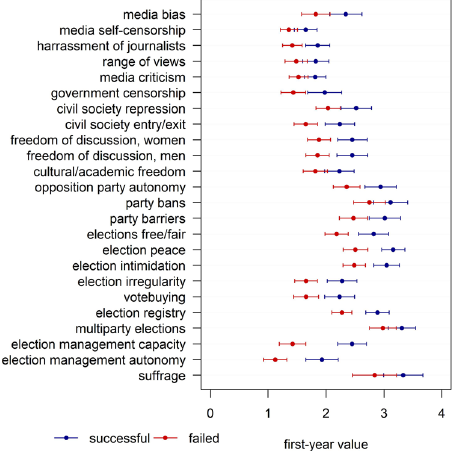
Fig. 2 Initial conditions of 24 democracy indicators for successful and failed liberalization episodes. Successful (blue) and failed (red) episodes signi fi cantly differed on 16 of the 24 democracy indicators in the year the episode began (99.9 percent con fi dence